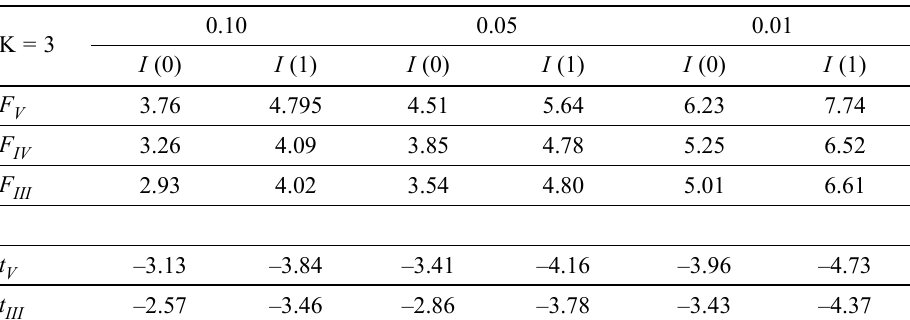
Table 3. Critical values for ARDL modeling